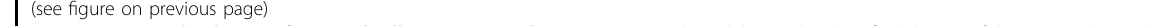
Fig. 1 Expression landscape of SBA and cell composition changes. a UMAP plot exhibiting the identi fi ed clusters of the STRT and 10× datasets. b UMAP plot exhibiting the cell tissue sources of the STRT and 10× datasets. c Dot plots presenting the normalized expression level of corresponding markers of each cell cluster in the STRT dataset. d Heatmap showing the average normalized GRN expression scores. e UMAP plot exhibiting the identi fi ed clusters of normal epithelial cells in the STRT and 10× datasets. f The upper panel exhibiting large-scale CNVs of single cells inferred based on normal epithelial cells in the STRT dataset. The middle panel exhibiting large-scale CNVs of single cells inferred based on epithelial cells from tumor tissues in the STRT dataset. The lower panel exhibiting the CNV called from the WES data of P3 – P6. g Histogram showing the cell composition percentage of each sample inferred by the deconvolution analysis. h Representative IHC staining of TAGLN in adjacent normal and primary tumor tissues (original magni fi cation 100×). The rows of the paired normal and tumor samples are from the same patients, and three individual patients are listed. Scale bar, 100 μ